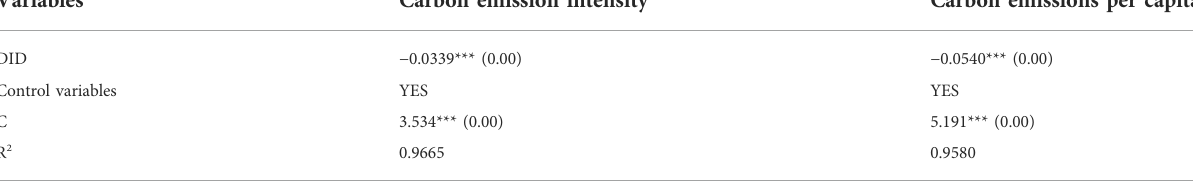
TABLE 2 Regression results of new urbanization pilot policies on carbon emissions.